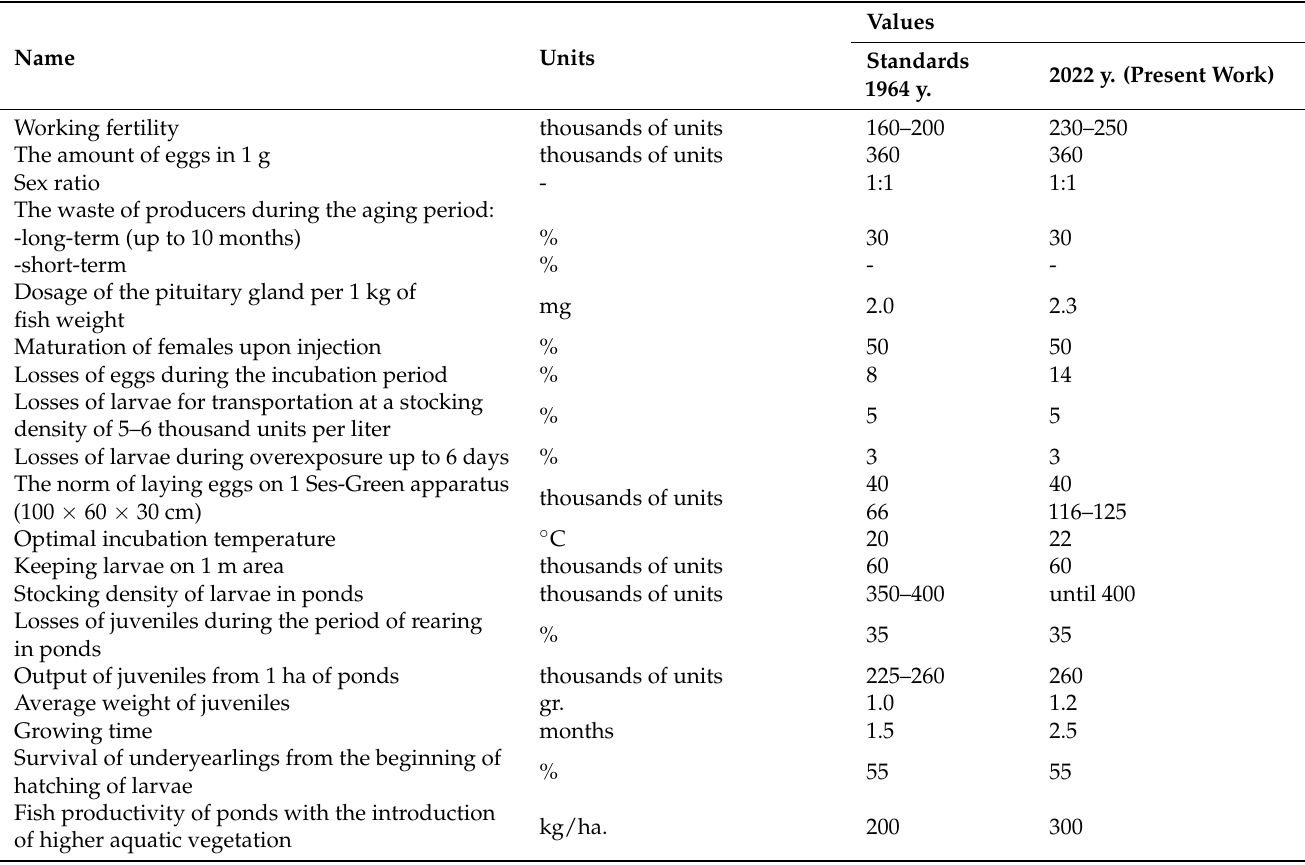
Table 2. Biotechnical standards for artificial breeding of the Aral